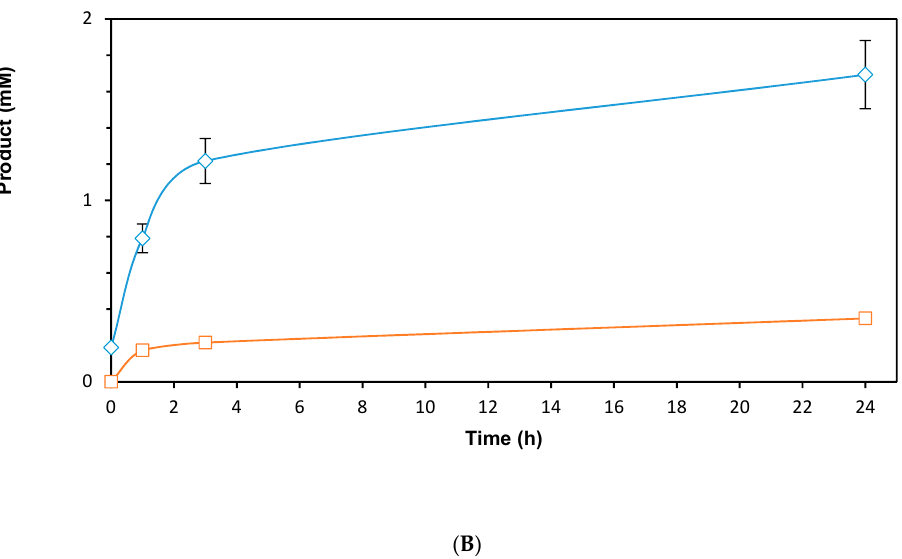
Figure 6. ( A ) Representative scheme of the ADH-A-catalyzed reduction of ethyl acetoacetate with Me FDH; ( B ) Time course of the reaction (blue diamonds) or without Me FDH (orange squares). Reaction conditions: 50 mM NaPi pH 7.0, ADH-A (0.6 U), [ Me FDH] = 5 µM (blue diamonds) or 0 µM (orange squares), [NAD] = 0.1 mM, [BNAH] = 10 mM (solid), [ethyl acetoacetate] = 10 mM, shaken at 30 °C, 800 rpm, anaerobic.